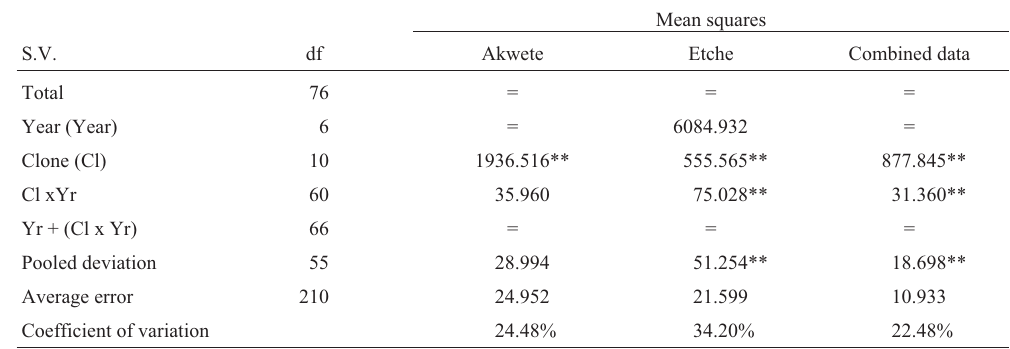
Table 2 - ANOVA for stability test of Hevea latex yield due to clone x year interaction in Akwete, Etche and combined data.